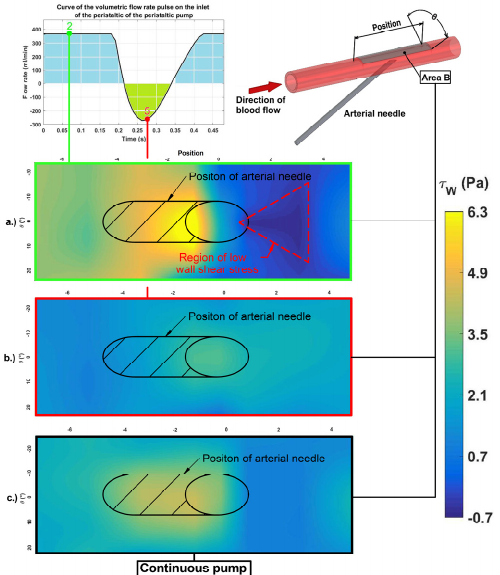
Figure 5. Wall shear stress distribution along the monitored area. The top right part of the figure shows part of the vascular access with a monitored area of WSS (grey, Area B). The position of the monitored area covers the area around the arterial needle. Graphs ( a – c ) show WSS distribution along the vessel wall in Area B. At point 2 of the pulse in Graph ( a ) the area with higher values of WSS can be found upstream of the needle. Low WSS can be observed up to 3 mm downstream from the center of the needle. The WSS reaches negative values in this area. At point 5 of the pulse in Graph ( b ) the insignificant maximum of the WSS values shift above the center of the needle inlet. Graph ( c ) represents the distribution of the WSS for the continual pump in the extracorporeal circuit. The WSS distribution is similar to that of pulse point 2. The WSS does not achieve negative